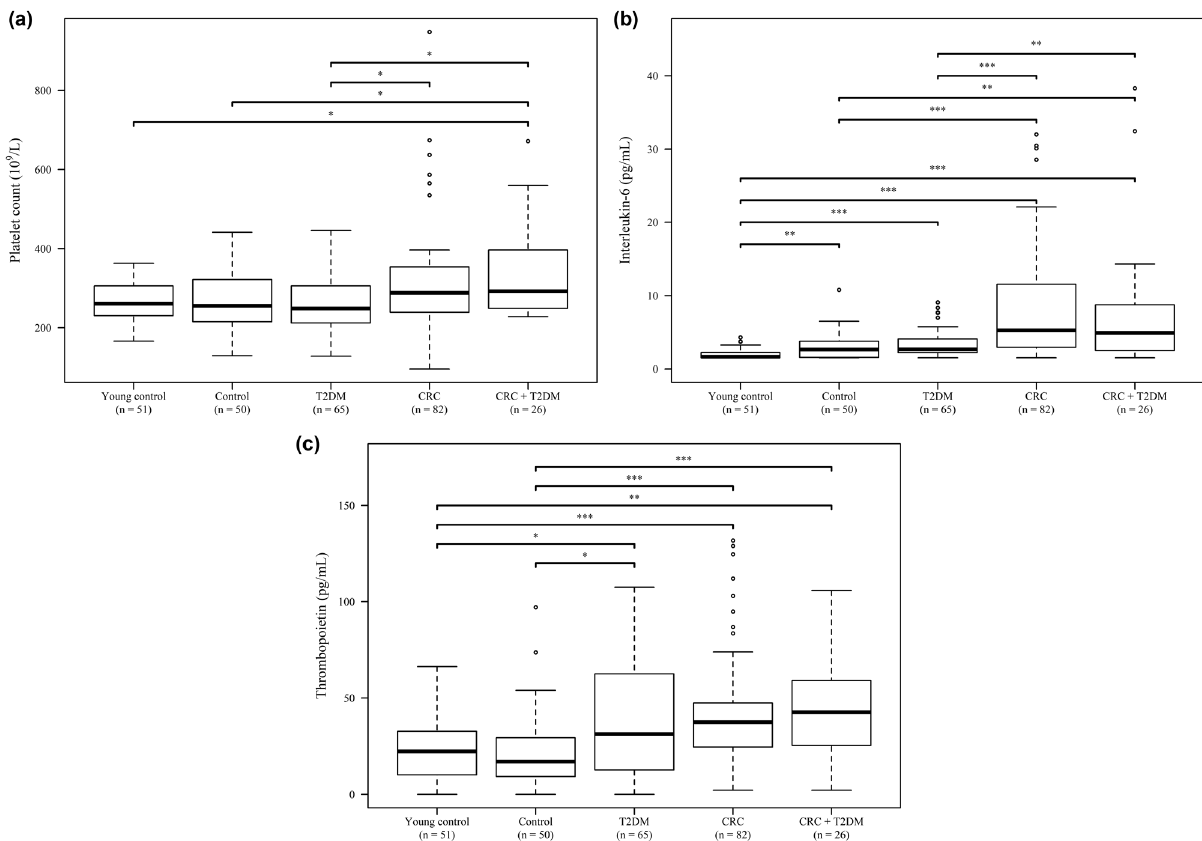
Figure 1: Comparison of paraneoplastic thrombocytosis - related parameters within the fi ve study groups. ( a ) The platelet count was signi fi cantly higher in CRC patients with T2DM, compared to those in all control groups, and it also di ff ered between the CRC and T2DM groups. ( b ) The plasma interleukin - 6 level was signi fi cantly higher in all tumor patients 1 , whereas ( c ) the plasma thrombopoietin level was signi fi cantly lower within the T2DM and CRC , and signi fi cantly higher in the CRC + T2DM groups, compared to those of control subjects. Note: p - value correction was used for all between - groups comparisons. 1 Due to better visibility, six and one outlier ( s ) over 40 pg/mL were not shown in the CRC and CRC + T2DM groups; maximum values were 220.20 and 77.19 pg/mL,